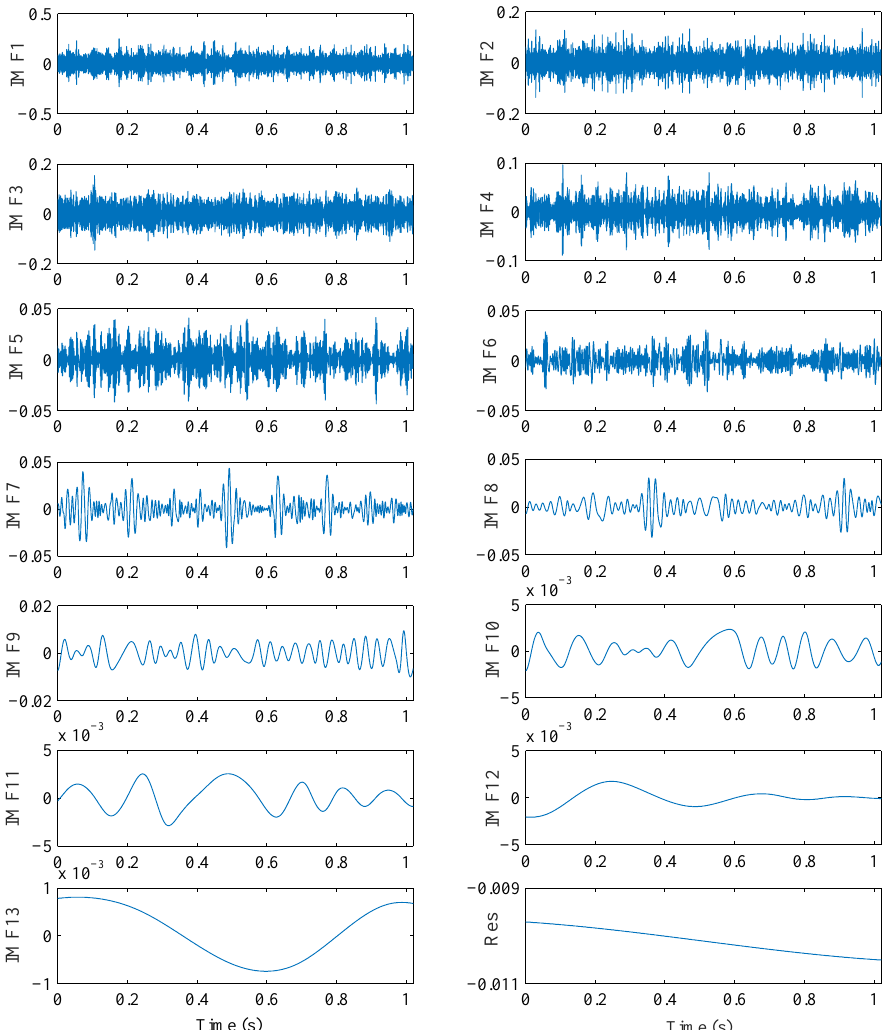
Figure 5. IMFs of the original signals achieved by CEEMDAN.